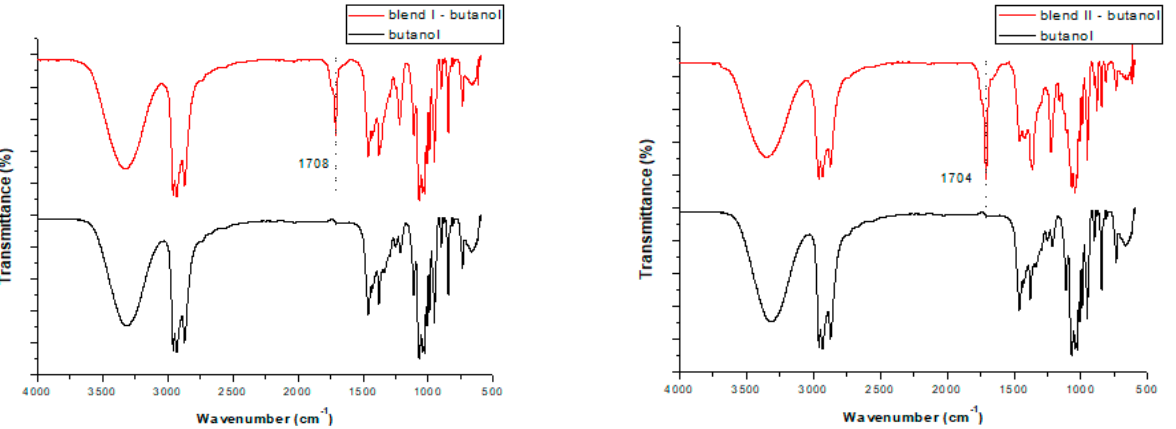
Figure 4. FTIR spectra of the pure butanol and butanol received after applying 6 h soxhlet extraction in the cases of blend I (left) and blend II (right).